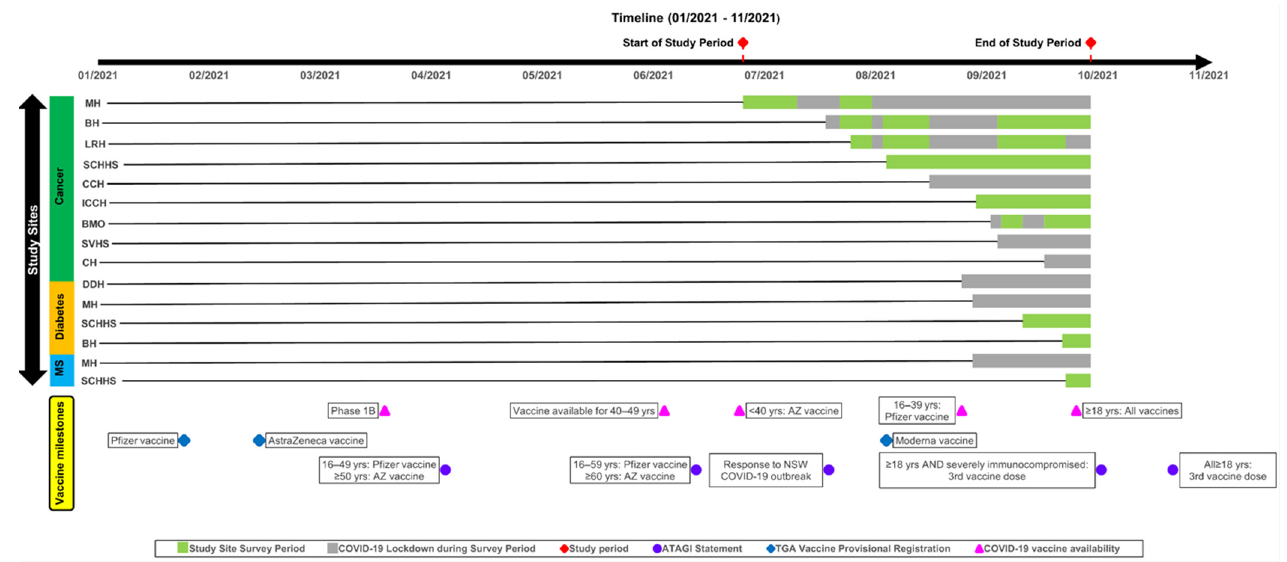
Figure 1. Timeline of study including survey period relative to statewide strict lockdowns for COVID ‐ 19 and vaccine milestones. Abbreviations: MH, Monash Health; BH, Bendigo Health; LRH, Latrobe Regional Hospital; SCHHS, Sunshine Coast Hospital and Health Service; CCH, Central Coast Hematology; ICCH, Icon Cancer Centre Hobart; BMO, Border Medical Oncology; SVHS, St Vincent’s Hospital Sydney; CH, Campbelltown Hospital; DDH, Dr David Hoffman; Yrs, Years; AZ, Astra ‐ Zeneca; NSW, New South Wales; ATAGI, Australian Technical Advisory Group on Immun ‐ ization; TGA, Therapeutic Goods Administration—COVID ‐ 19 Vaccine Provisional Registration. People diagnosed with either cancer, diabetes, or MS were eligible for COVID ‐ 19 vaccination from the commencement of the Australian Government Rollout Phase